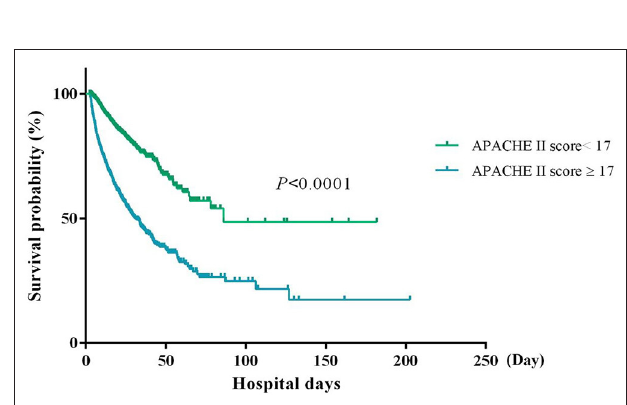
FIGURE 4 | The Kaplan-Meier survival curve of patients with an APACHE II score ≥ or <